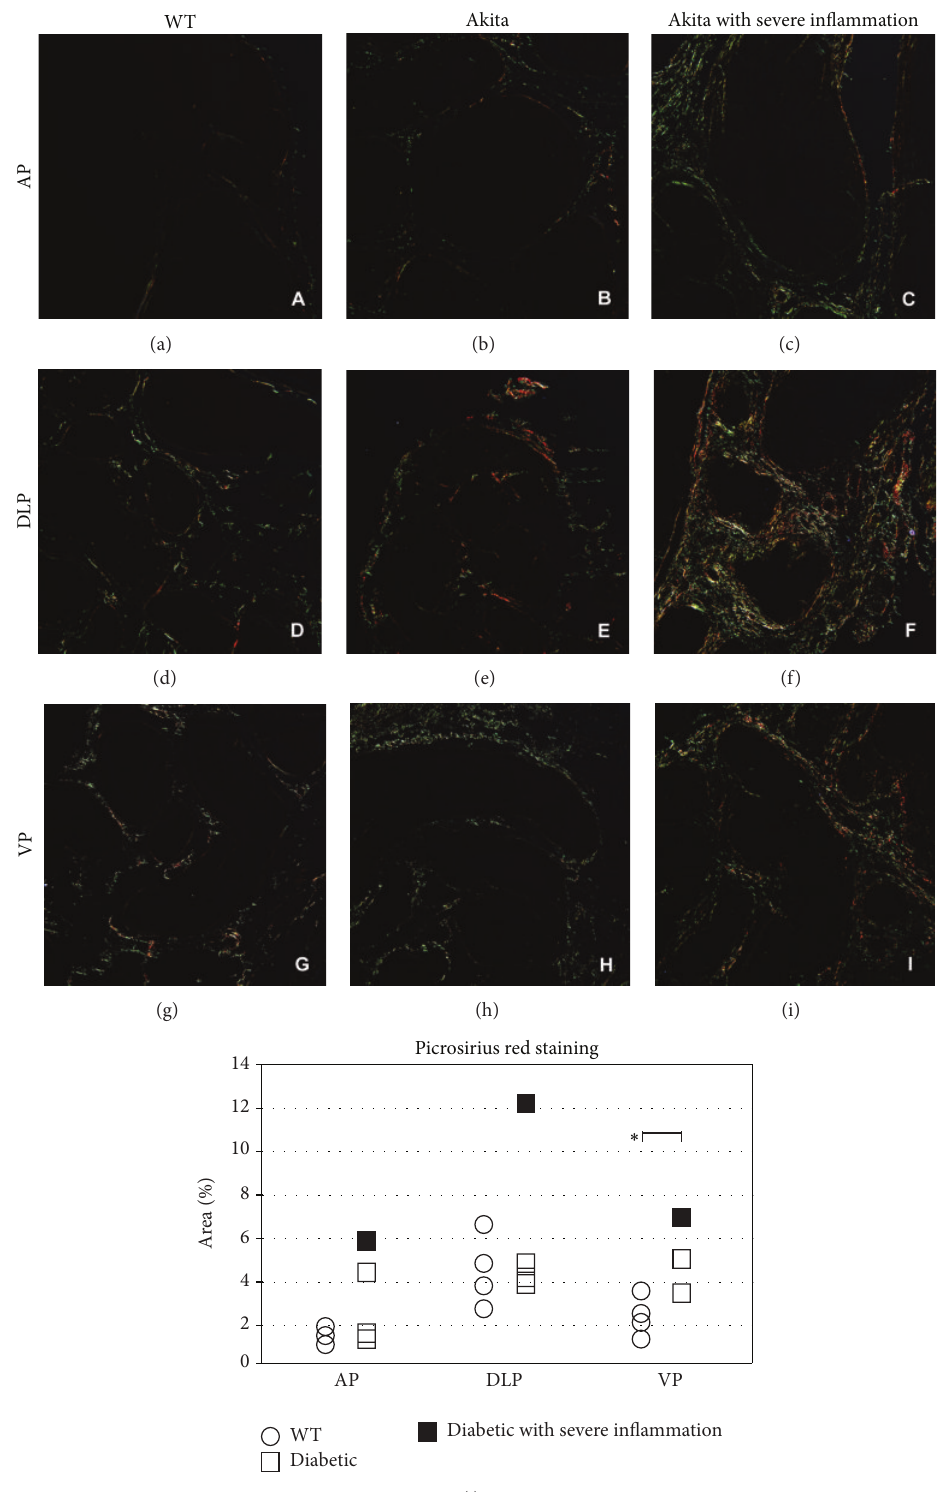
Figure 3: Representative section of the AP, DLP, and VP of 18-week-old DBA2J (WT; (a), (d), and (g)), DBA2J.Ins2-Akita (diabetic; (b), (e), and (h)), or DBA2J.Ins2-Akita with severe inflammation (diabetic; (c), (f), and (i)) stained for collagen with picrosirius red. Quantification results of collagen level in (a) ∼ (i) ((j), white circles = WT, white squares = Akita, and black squares = Akita with severe inflammation). ∗ 𝑃 value <